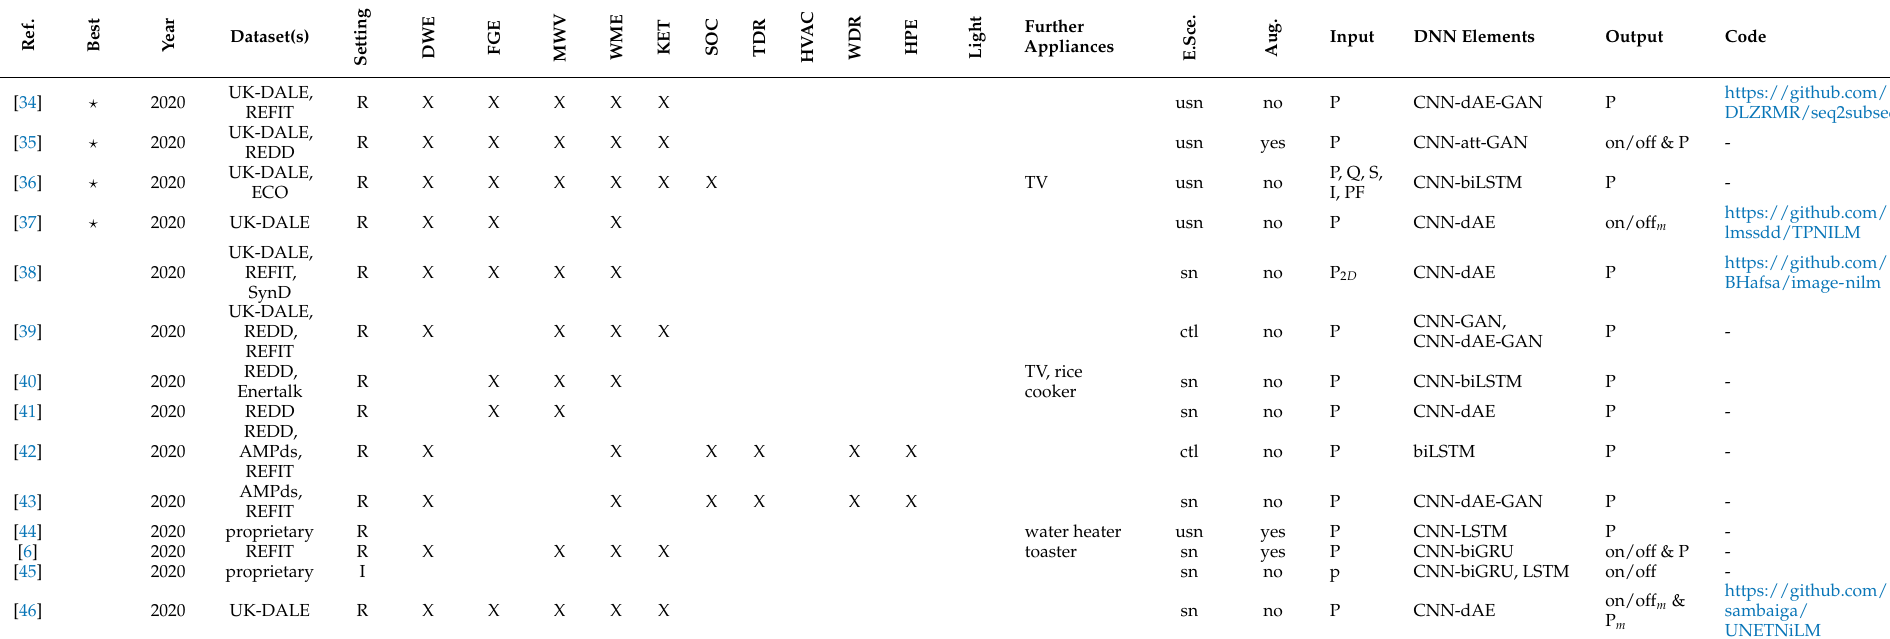
Table 2. Reviewed references. Publications are sorted by year. Except for the starred publications, the sorting within a year is arbitrary. The table is available in Excel format on our GitHub account, see ’Supplementary Materials’ for the link. Explanations with respect to specific columns follow. Best : Best performing, according to Section 4.1. Datasets : See Table 3 for details. Setting : R → residential, I → industrial, C → commercial. The columns FGE to WDR indicate if the specific appliance has been disaggregated in the reference. FGE : fridge, DWE : dishwasher, MWV : microwave, WME : washing machine, KET : kettle, SOC : stove/oven/cooker, TDR : tumble dryer, HPE : heat pump, WDR : washer-dryer. Further Appliances : Additional appliances not listed in the previous columns. E.Sce. : Evaluation Scenarios; sn → only seen scenario evaluated, usn → additionally unseen scenario evaluated, ctl → also cross-domain transfer learning evaluated. Aug. : Data Augmentation; dn → use synthetic training data, yes → data augmentation employed. Input ; P → active power, Q → reactive power, I → current, S → apparent power, P 2 D → active power window transformed into 2D representation, P-S → difference between active and apparent power, ∆ P → first-order difference of the active power signal, PF → power factor, TofD → time of day, WE → week or weekend day, DofW → day of week, MofY → month of year, T out → outdoor temperature, P var → variant power signature [32,33], na → see Section 3.3.1. DNN Elements : See Section 3.4.1 for the meaning of the various employed abbreviations. Comma separated descriptions refer to different trained models. Output : Comma separated descriptions refer to different trained models. Elements connected with an & indicate that a DNN has several outputs of a different type. Similarly, the subscript m means that the DNN provides the identical output for multiple different appliances. on/off → on/off status of appliance, P class → class of active power. Please refer to Section 3.5 for details concerning P app , P total , P rest , location , and stateChange . Code : (electronic version) link to code repository as indicated in the reference or found through a very shallow google